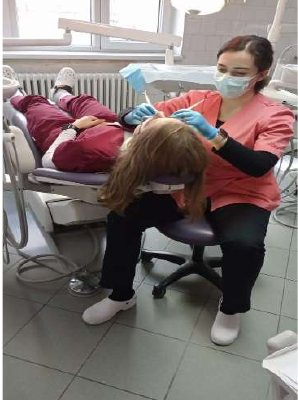
Figure 2. Photograph used to assess lamp position, head position, back position, doctor and patient chair position, leg position and visibility of the operatory field in accordance with ISO11226. These elements were marked on the photograph and numbered from one to seven, for a better evaluation.